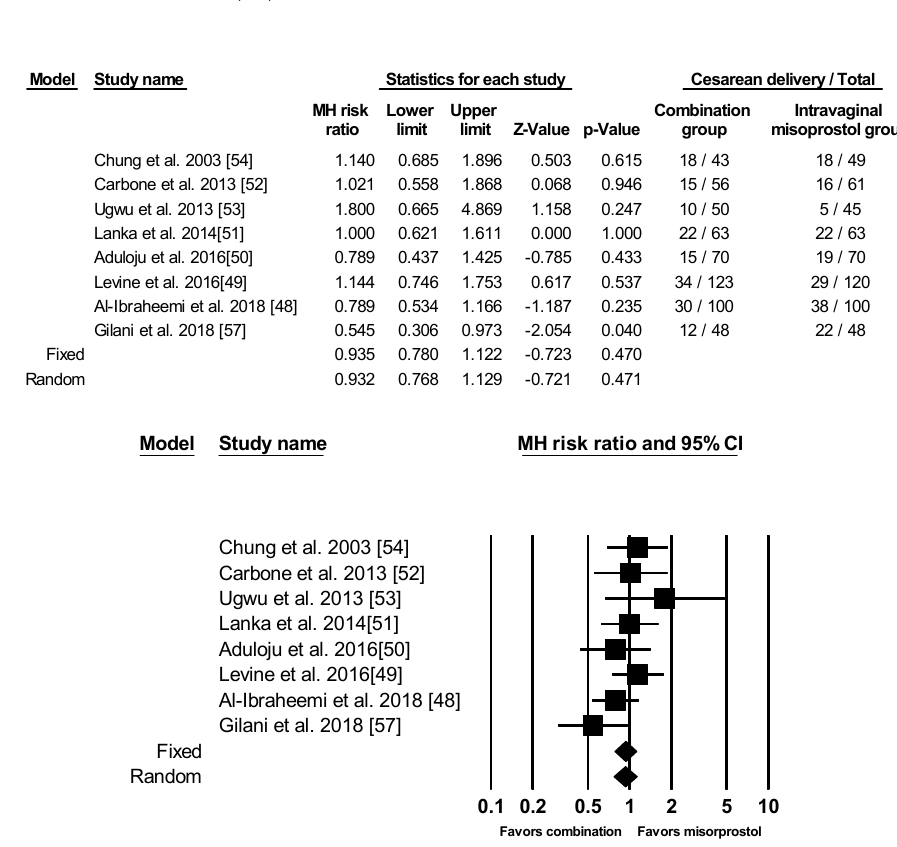
Figure 5. Comparison 4: Combination of intracervical Foley catheter and intravaginal misoprostol versus intravaginal misoprostol alone for cervical ripening, Outcome 4: Cesarean Section. Heterogeneity: Tau 2 = 0.006; ꭓ 2 = 7.631, df = 7 ( p = 0.366); I 2 = 8.266%. Test for overall effect (fixed): Z = − 0.723, ( p = 0.470).